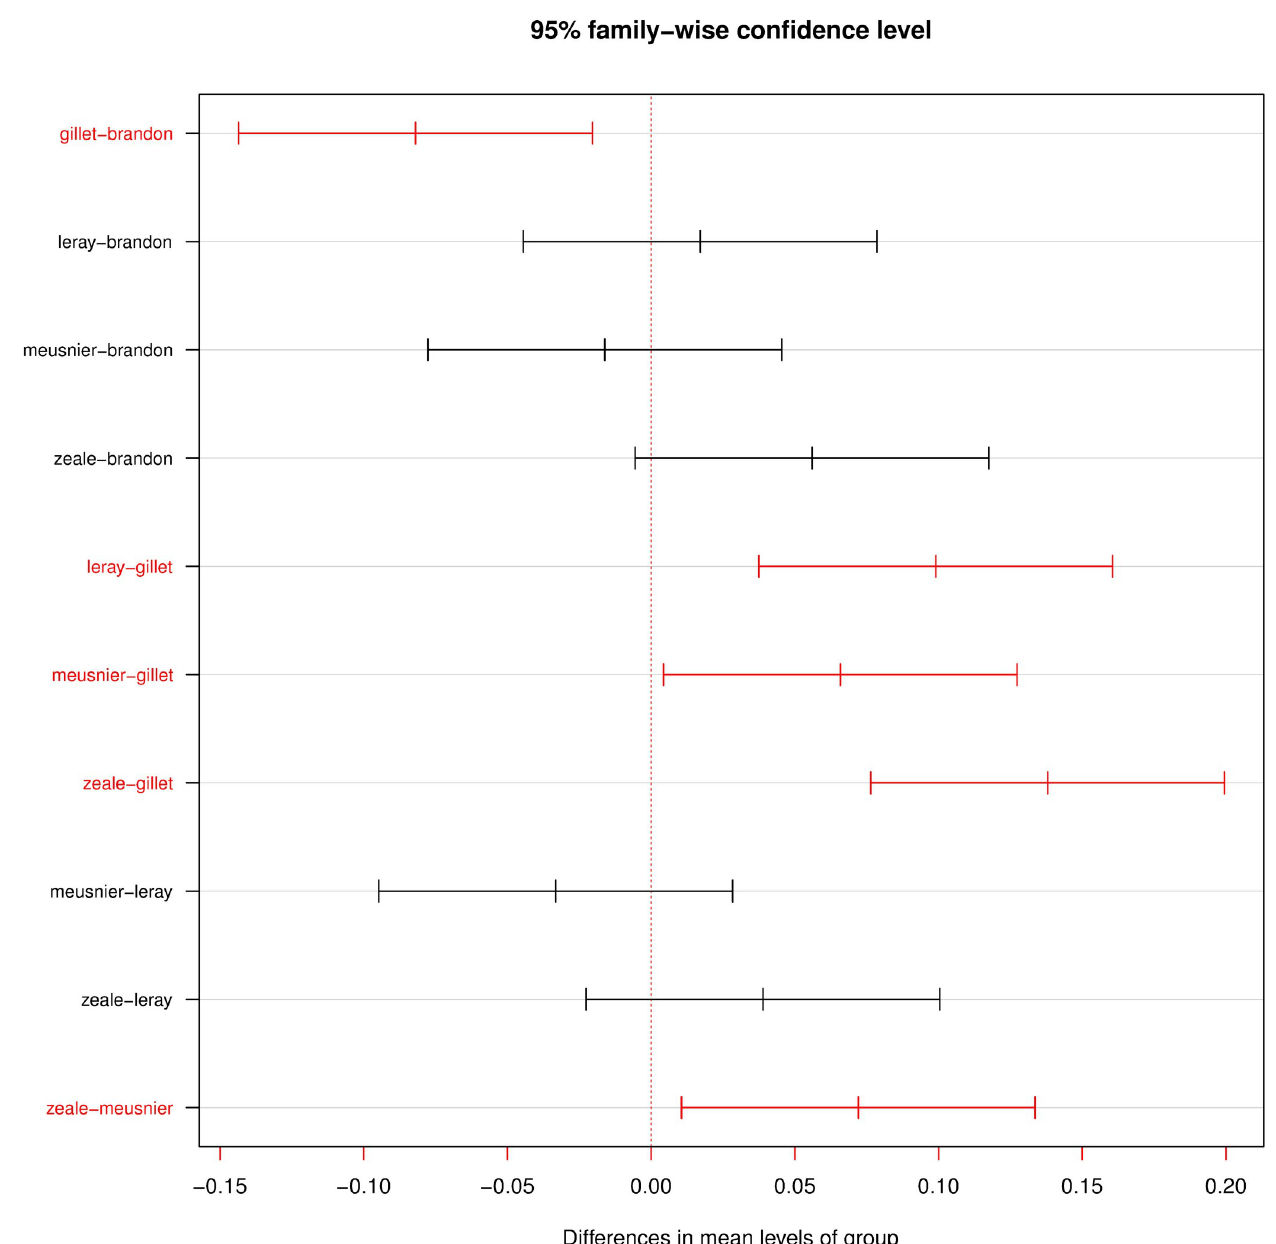
Fig 6. Tukey’s HDS plot for all the comparisons between primer sets. Red colour represents significant differences (p < 0.05). The plot shows the differences in mean levels of groups where the largest difference in homogeneity was between Gillet and Zeale, followed by Gillet and Leray.